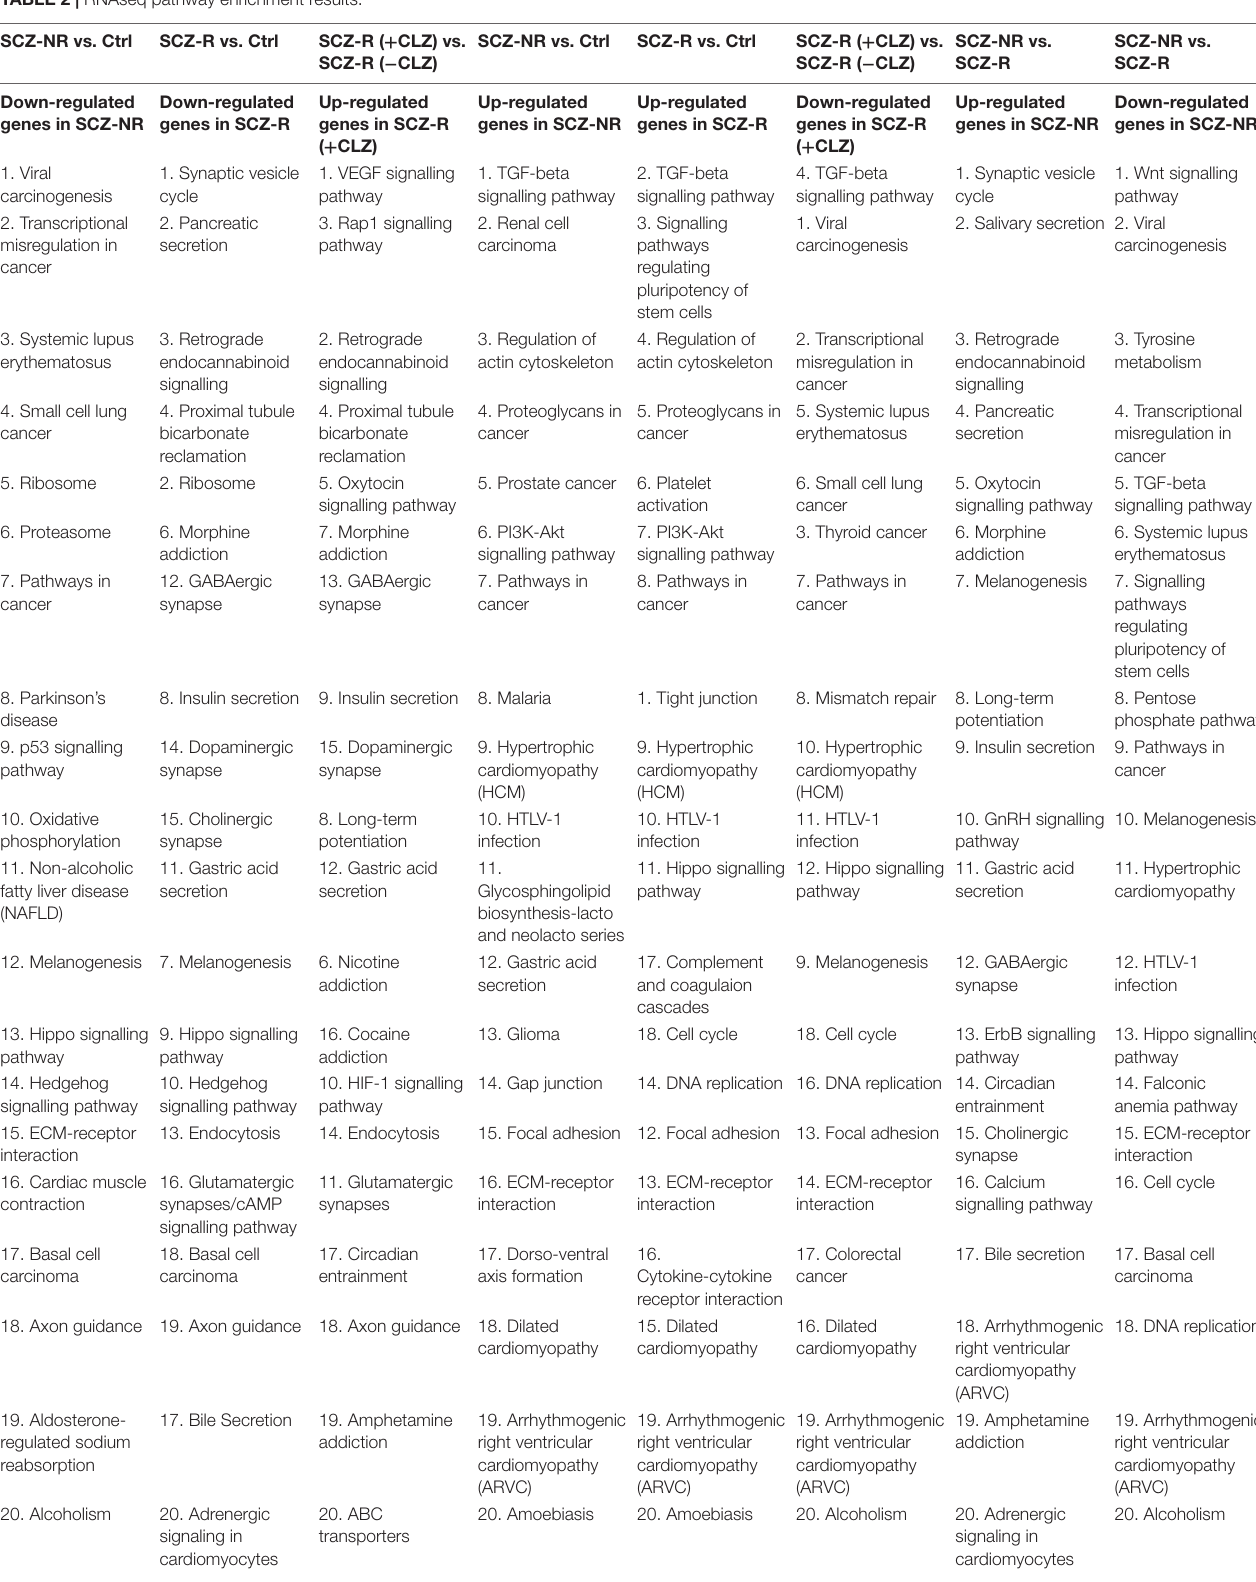
TABLE 2 | RNAseq pathway enrichment results. SCZ-NR vs.